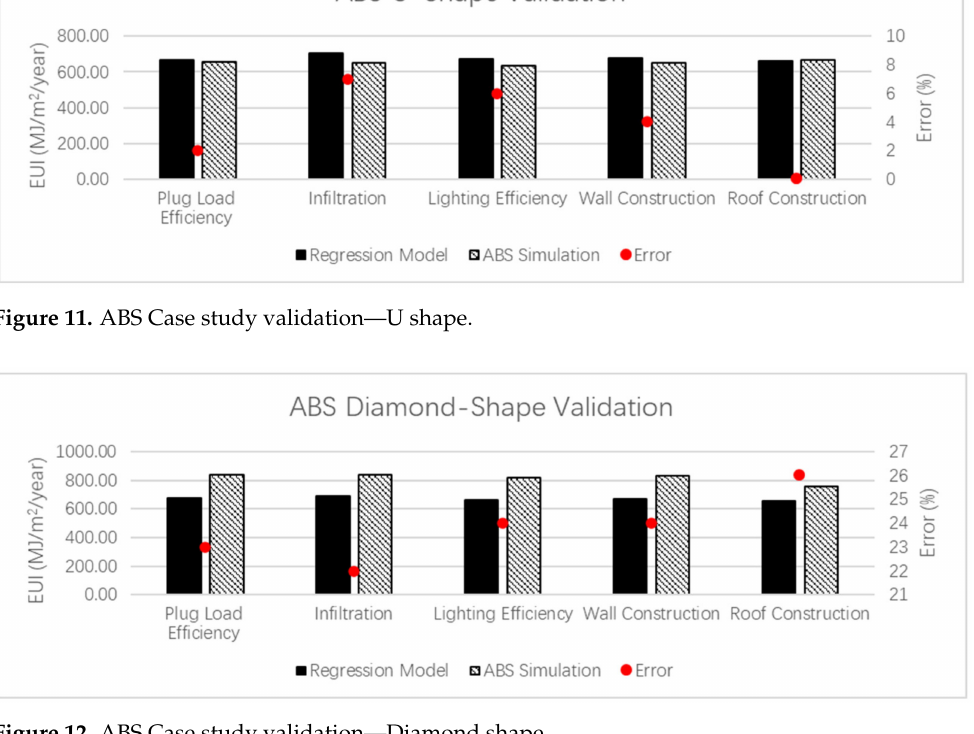
Figure 12. ABS Case study validation—Diamond shape.